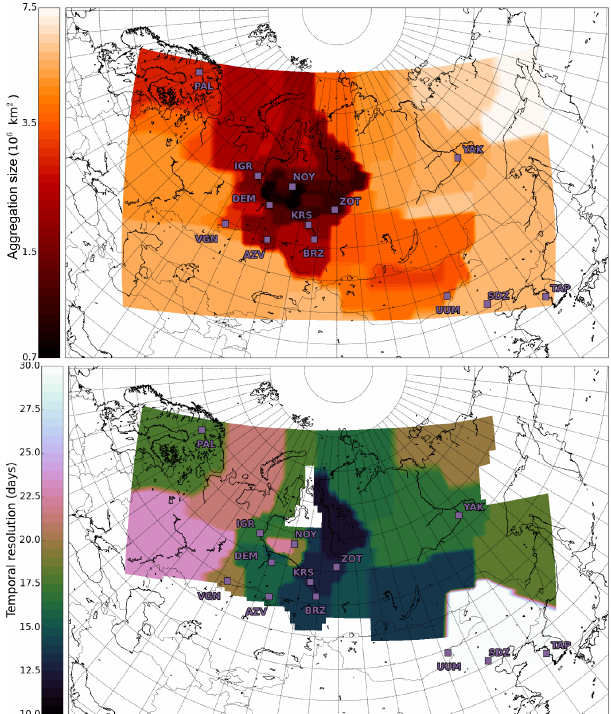
Figure 4. Temporal and spatial resolutions solved by the inversion. (Top) Typical sizes (in km 2 ) of aggregation groups (as defined in Sect. 2.3.2); for each pixel, the size of the group the pixel belongs to is averaged along the whole period of study. (Bottom) Timescales (in days) resolved for wetland emissions; the period covered by pixel groups is averaged along the